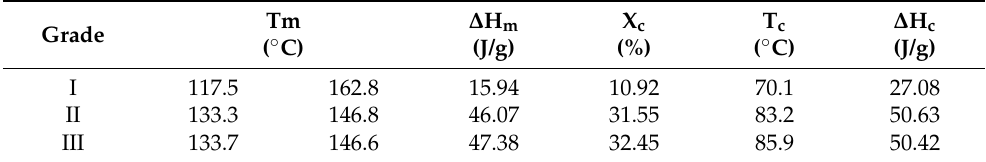
Table 3. Thermal properties of PHBH polymer